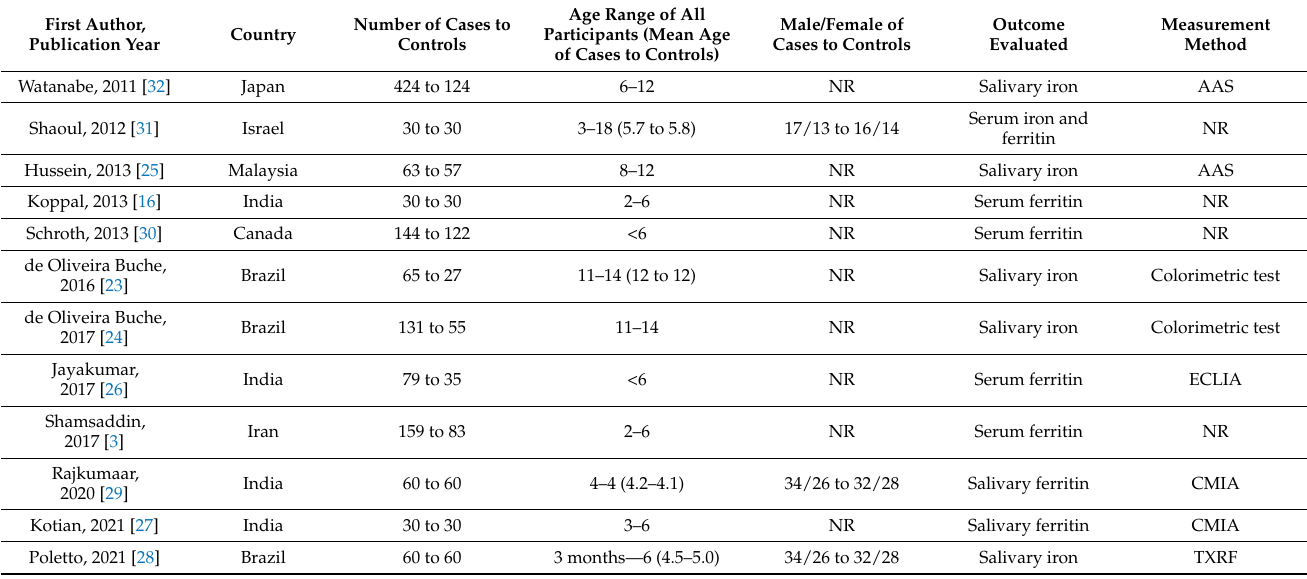
Table 1. Characteristics of the studies included in the meta-analysis.